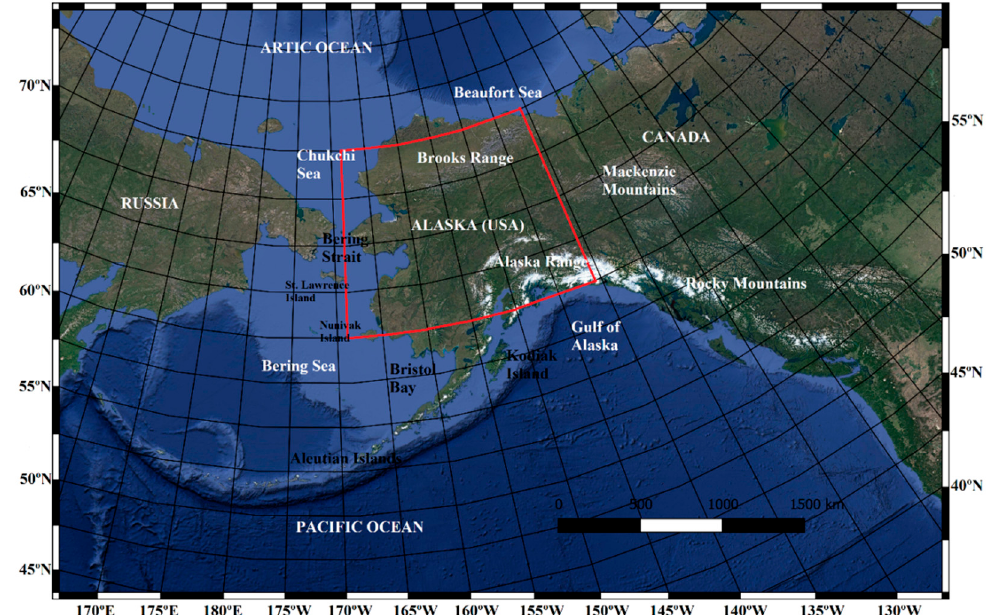
Figure 1. The study region (70° N, 168°30 ′ W; 60° N, 141° W). Boreal forest (green) is differentiated from all the other land covers (brown) and water bodies (blue).